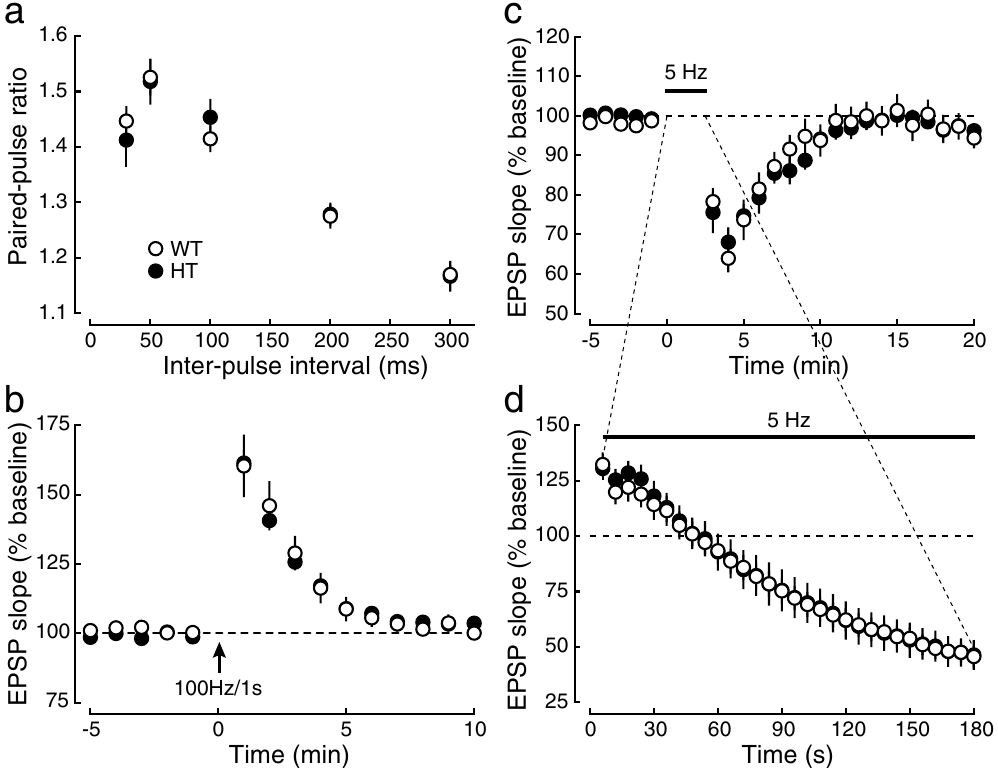
Figure 4. The decrease in the expression of SNAP-25 protein in KI mice is not associated with the impairment in basal synaptic transmission and presynaptic short-term plasticity. ( a ) The paired-pulse ratio was indistinguishable between HT (closed circles: ● , n = 8) and WT mice (open circles: ○ , n = 9) at all inter- pulse intervals. ( b ) PTP induced by tetanic stimulation (100 Hz, 1 s) in the presence of 50 μ M D-APV in HT mice (closed circles: ● , n = 4) was not significantly different from that in WT mice (open circles: ○ , n = 5). ( c , d ) Synaptic responses during 5-Hz stimulation ( d ) and synaptic depression after the stimulation ( c ) were indistinguishable between HT (closed circles: ● , n = 5) and WT mice (open circles: ○ , n =